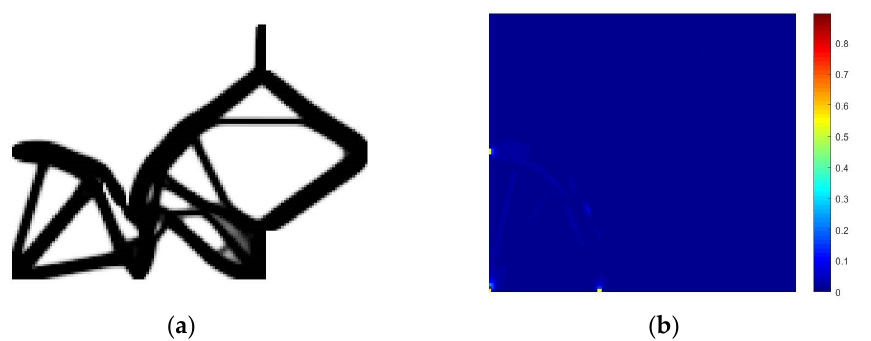
Figure 14. Design result of the inverter ( a ) using Equation (19) and the distribution of the local strain energy density ( b ).